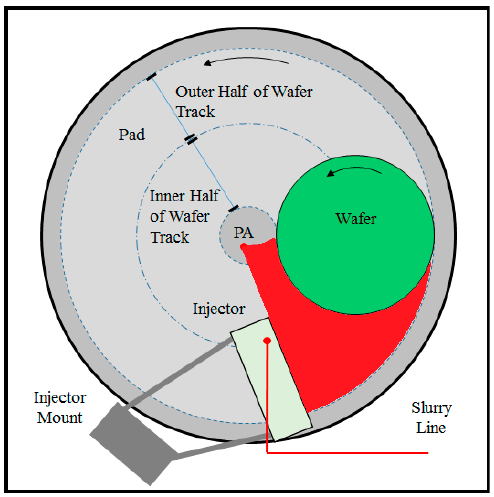
Figure 6. Coverage of fresh slurry on wafer track (red) using a hybrid system.